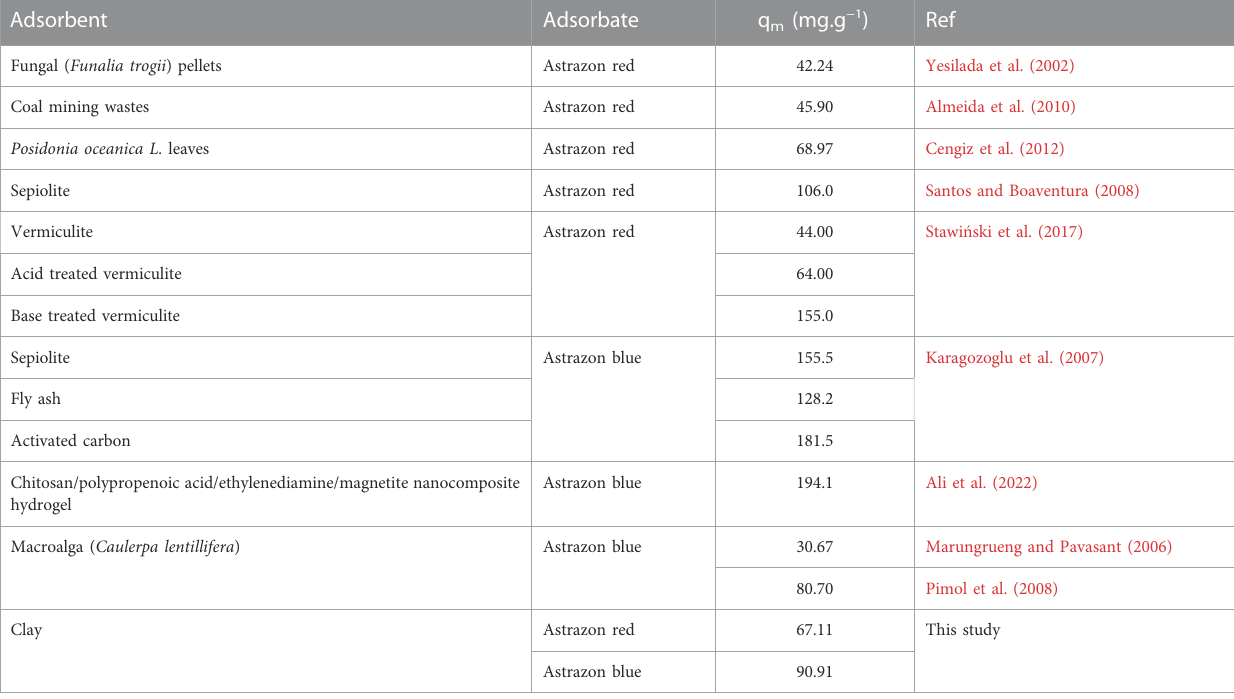
TABLE 5 The monolayer adsorption capacities of some adsorbents for astrazon blue and astrazon red adsorption.